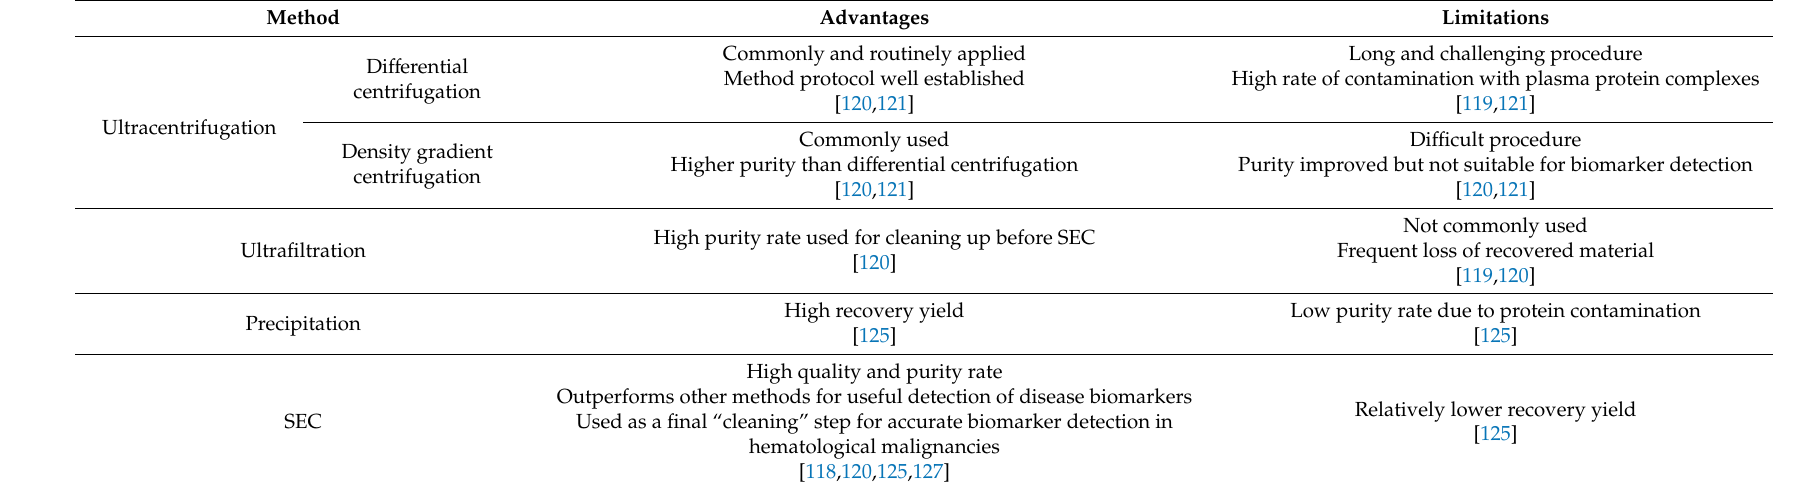
Table 3. Summary of the methods used for isolation and purification of plasma and serum EVs in the context of liquid